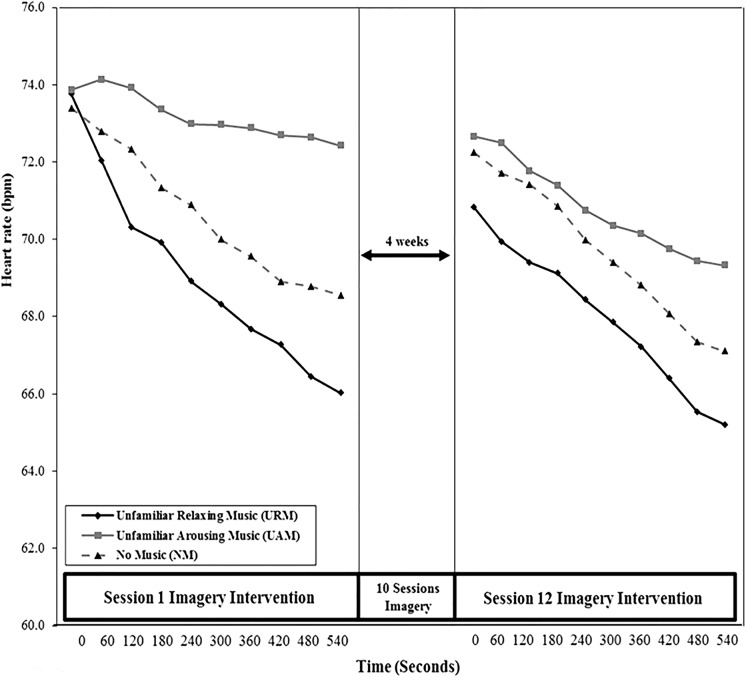
Mean heart rate (HR) from t0 to t540 across Sessions 1 and 12.